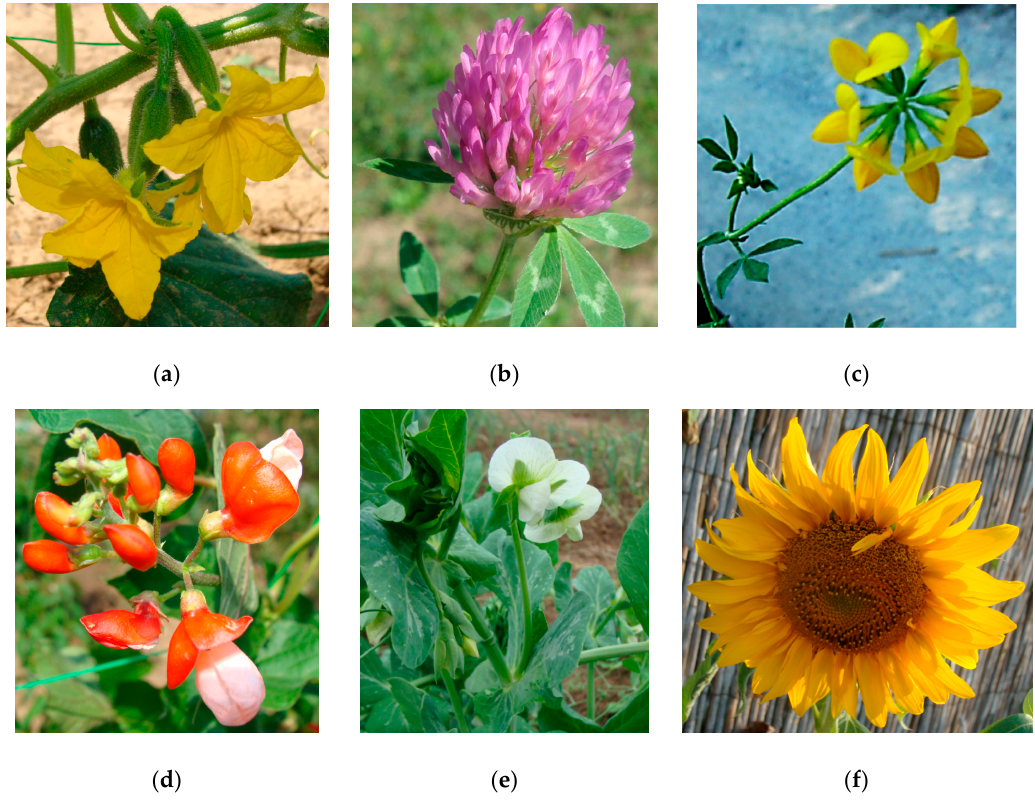
Figure 13. Examples of terrestrial plant species recommended for ecotoxicity assessment by standard guidelines: ( a ) Cucumis sativus (cucumber); ( b ) Trifolium pratense (red clover); ( c ) Lotus corniculatus (common birdsfoot trefoil); ( d ) Phaseolus vulgaris (common bean); ( e ) Pisum sativum (pea) and ( f ) Helianthus annuus (sunflower).